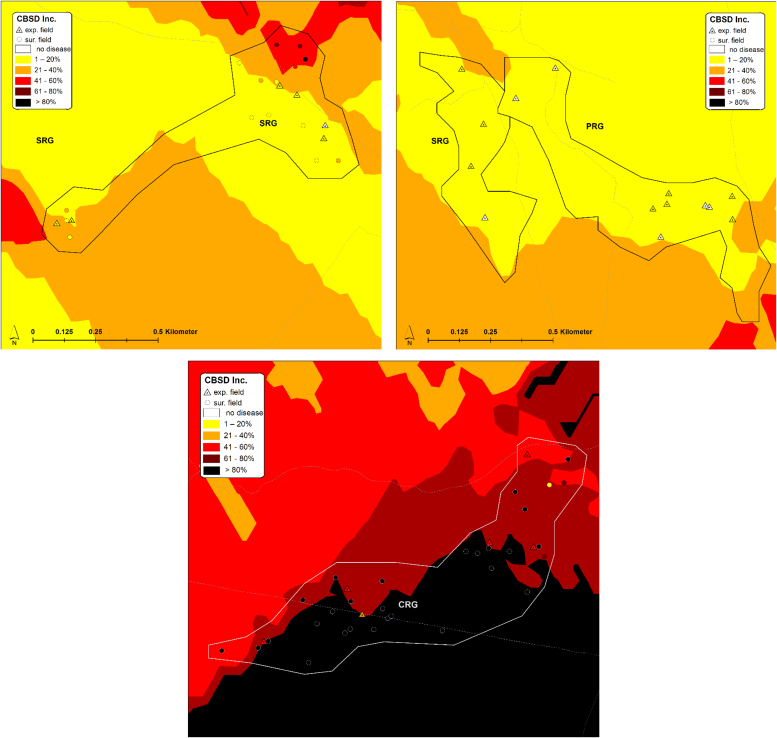
CBSD incidence in experimental (monitored) and surrounding fields in the PRG, SRG and CRG areas of Mkuranga, eastern coastal Tanzania. CBSD incidence data from all fields were used to develop an interpolated spatial plot of CBSD incidence using Kriging techniques.